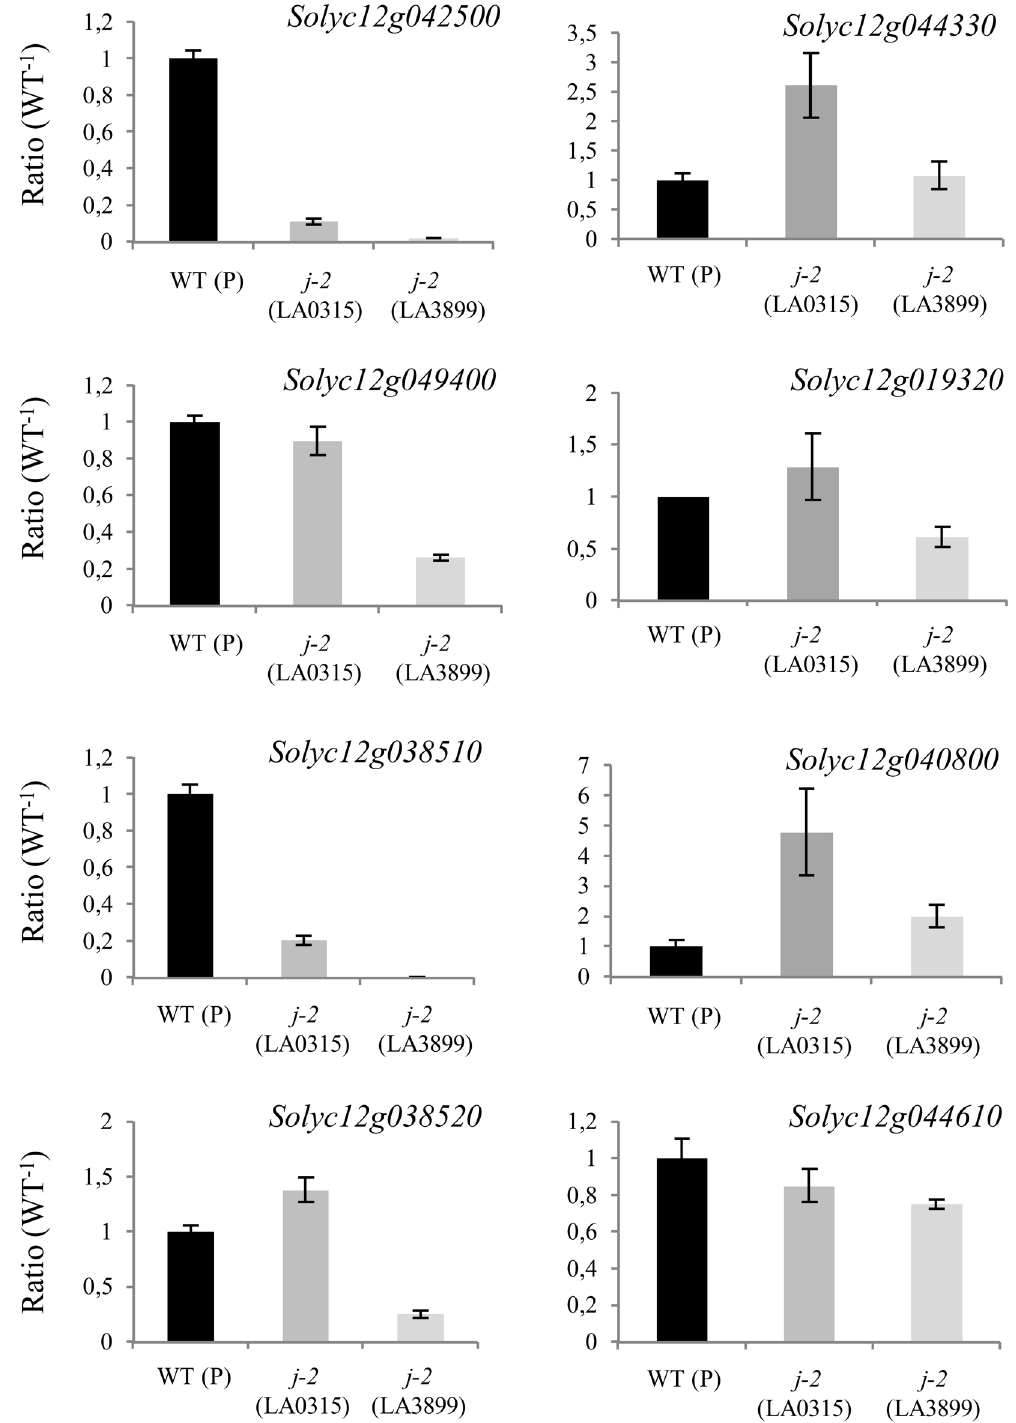
Figure 3. Expression levels of candidate genes in j-2 mutants, relative to WT. The selected genes are expressed in the AZ and located in TG618-CD22 genetic interval. WT (P, Pearson) and j-2 flower pedicels were used as plant material. Bars =